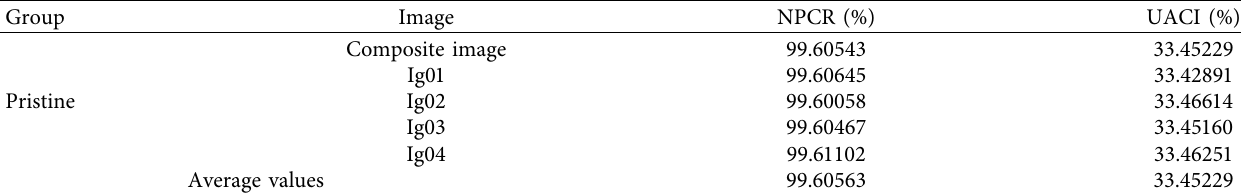
Table 4: Outcomes of NPCR and UACI for slight changes in the pristine composite